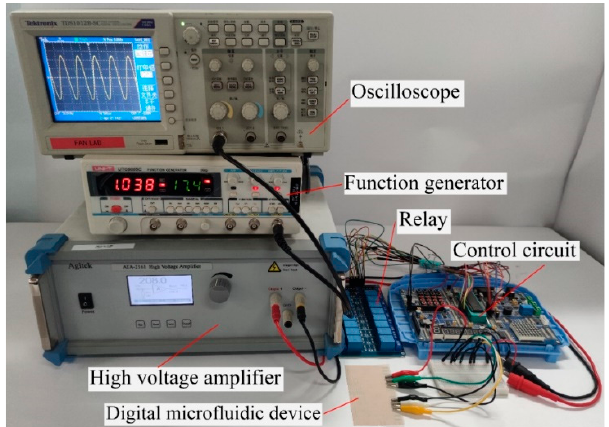
Figure 3. Testing system setup for the digital microfluidic device. The function generator provides the AC signal and is amplified with a high-voltage amplifier. A control circuit with microcontroller was used to control the AC voltage supply to each electrode on the digital microfluidic